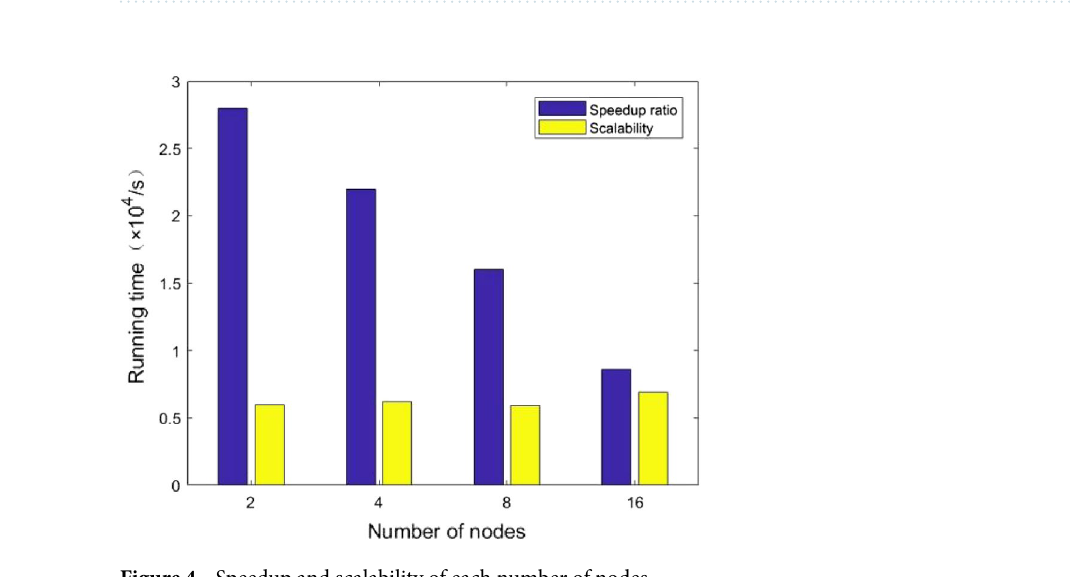
Figure 4. Speedup and scalability of each number of